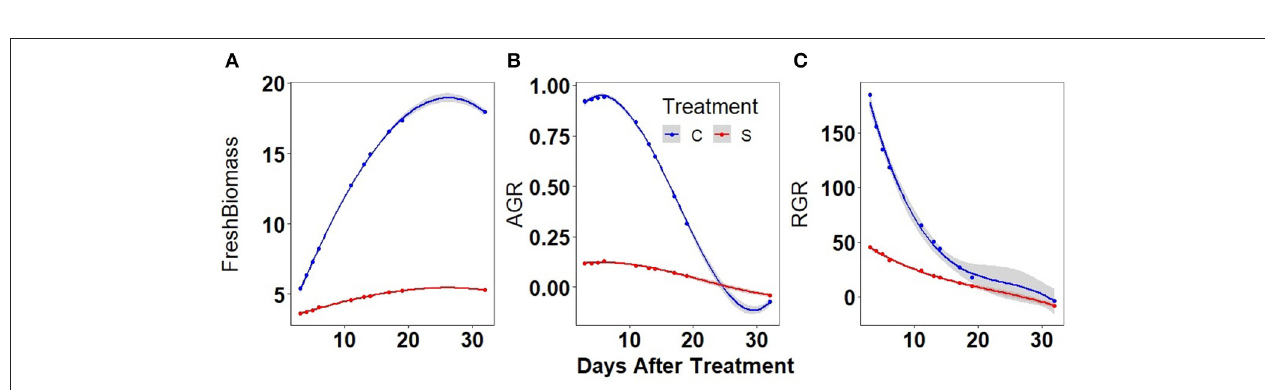
FIGURE 3 | Cross-validation output for the final PLS model. The “cv.lm” function of “DAAG” package was used for simple linear regression models. The k -fold method randomly removes k -folds for the testing set and models the remaining (training set) data. Here, we use the commonly accepted 10-fold application. The figure depicts the cross-validation residual sums of squares, which is a corrected measure of prediction error averaged across all folds. The function also produces a plot of each fold’s predicted values against the actual outcome variable (y); each fold having a different color.